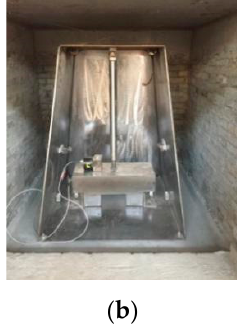
Figure 3. Tower dimensions and overall model. ( a ) Tower size; ( b ) Overall model.